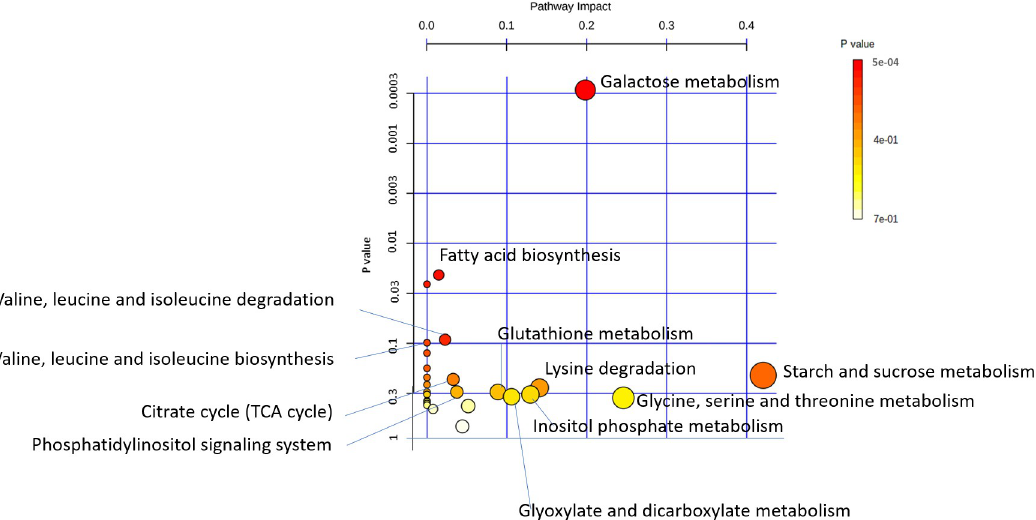
Fig 7. Pathway analysis of metabolites associated with AVS. Outputs of urine and plasma metabolomic profiling in AVS patients and control subjects were used to identify changes in biological pathways in the human Kyoto Encyclopedia of Genes and Genomes (KEGG, www.genome.jp/kegg) using the MetaboAnalyst web-tool (www.metaboanalyst.ca). Data are plotted to illustrate the most significantly altered pathways in terms of p-values derived from hypergeometric test on the vertical axis and impact on the horizontal